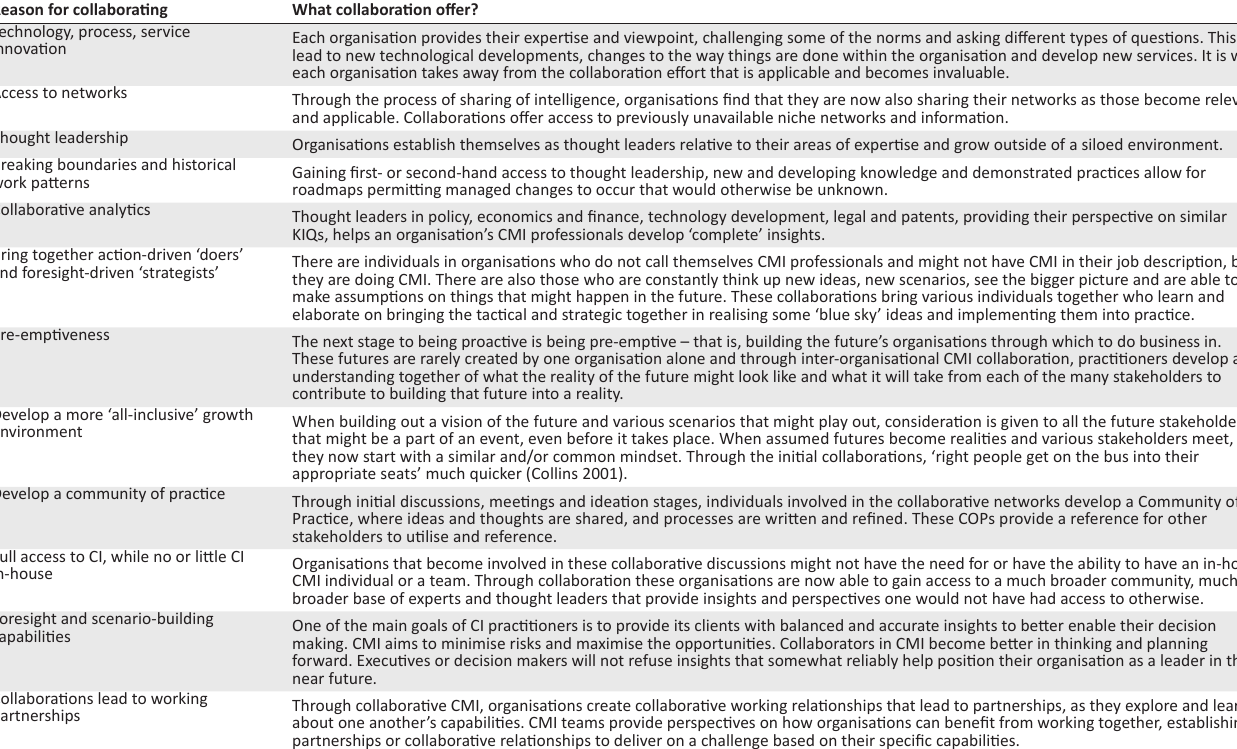
TABLE 1: The advantages of inter-organisational collaborations. Reason for